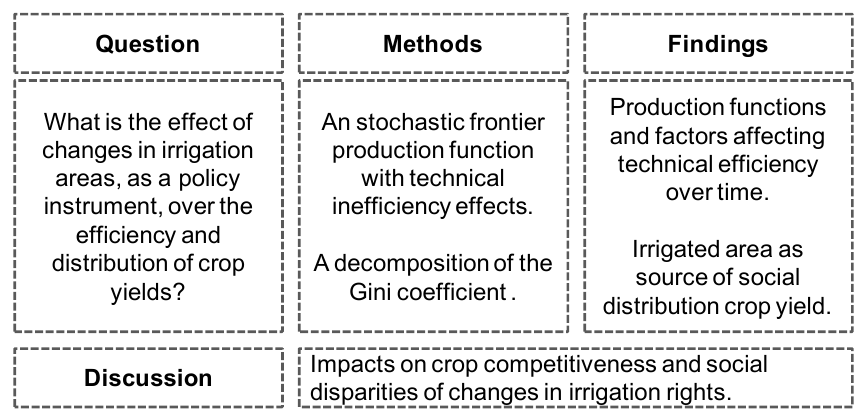
Figure 1. Steps on the